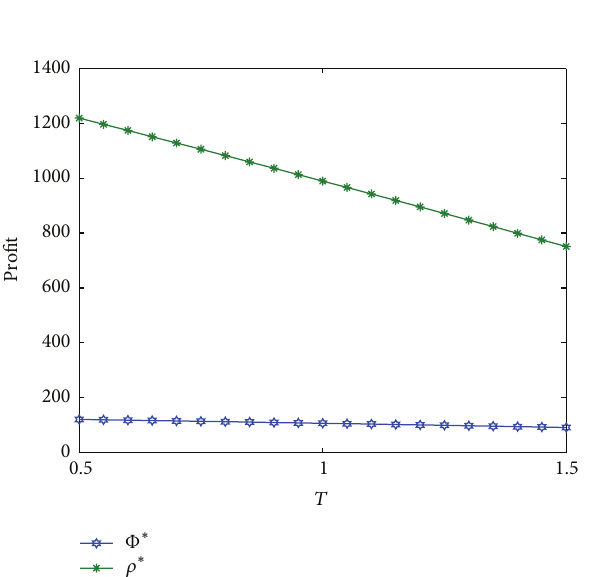
Figure 14: Impacts of 𝜆 on Ψ ∗ and 𝑓 ∗ .